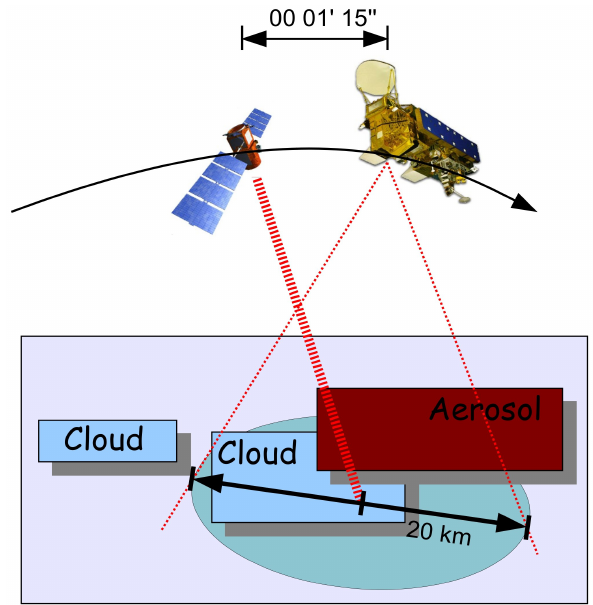
Fig. 1. Scheme of CALIPSO-MODIS coincidence methodology. When CALIPSO detects the presence of single-layer aerosol and cloud fields, we look for MODIS retrievals within a radius of 20 km from CALIPSO target. The temporal coincidence is insured by the coordinated satellite orbits.